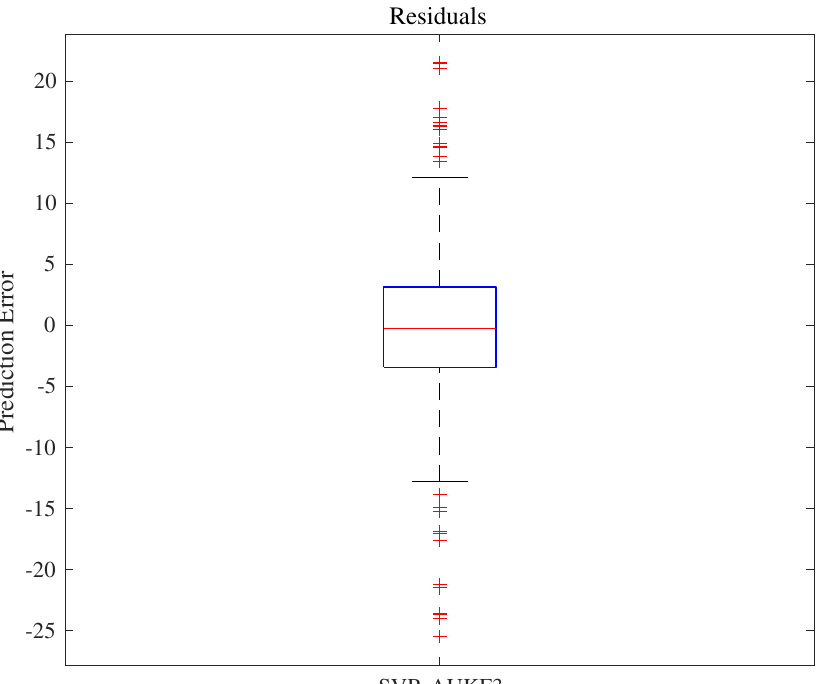
Figure 12. Boxplot of SVR-AUKF3 prediction